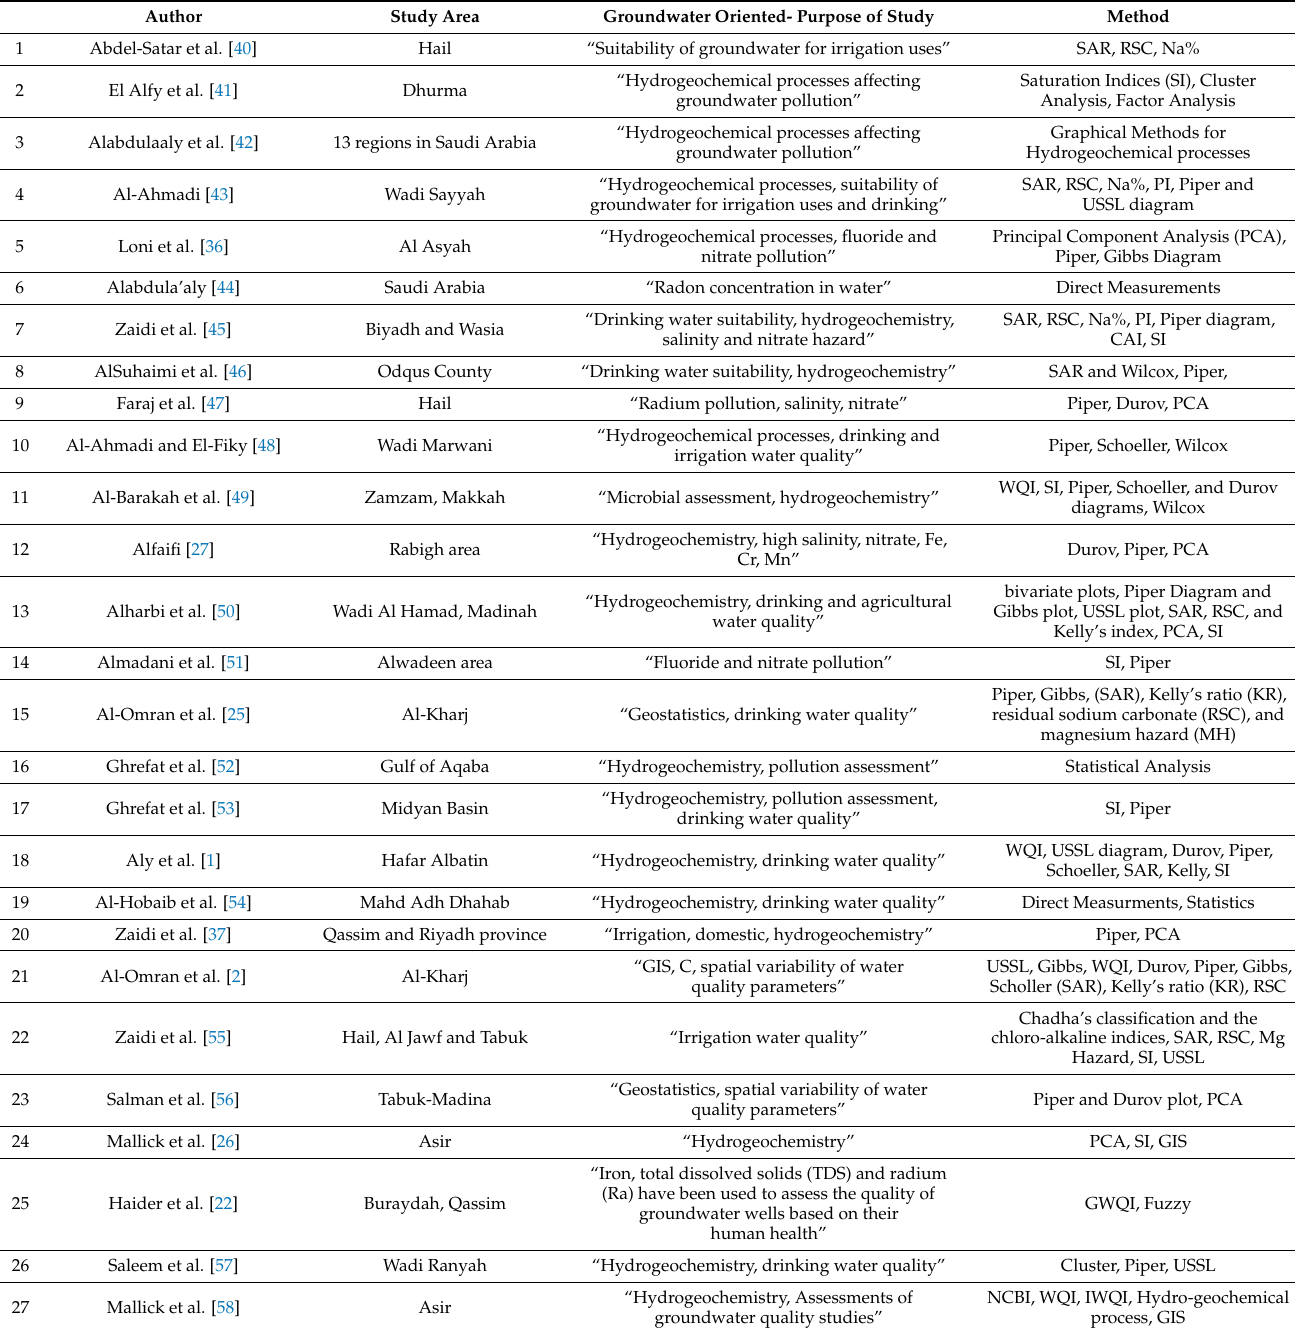
Table 2. Assessments of groundwater-quality studies (all the studies considered in the current review are field cum laboratory